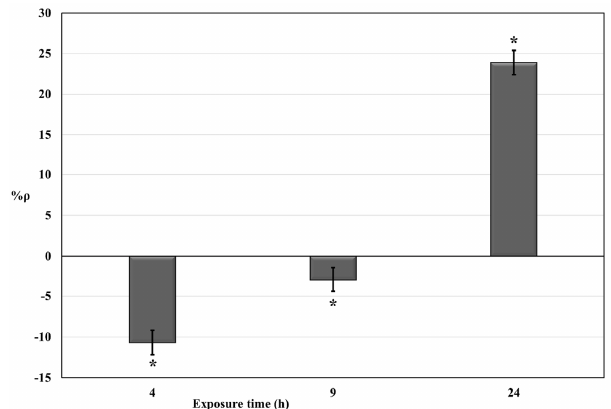
Figure 2. Dose-effect histogram of 5 µg/mL 2,4-DNP exposure (exposure times ≤ 24 h) of S. cerevisiae cell suspensions. %RSD ≤ 15%; ANOVA testing using randomized block design was applied for statistical differences between means values of Δ ppm O 2 exp and Δ ppm O 2 blk . Statistical significance of the results is indicated with asterisks (* p ≤ 0.05).